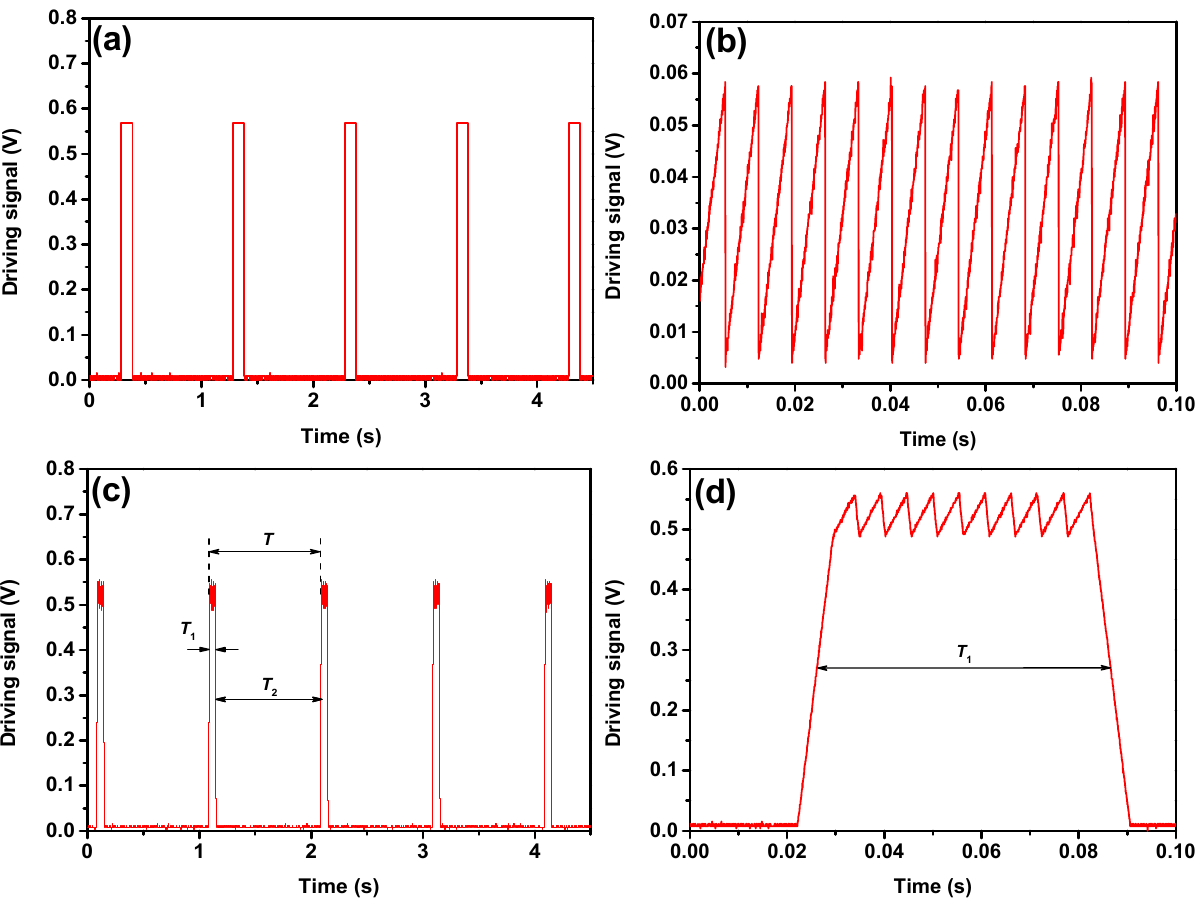
Figure 4. Laser driving signal. ( a ) Fixed wavelength pulse mode; ( b ) conventional direct absorption technology; ( c ) intermittent scanning technique; ( d ) working state in intermittent scanning tech- nique.